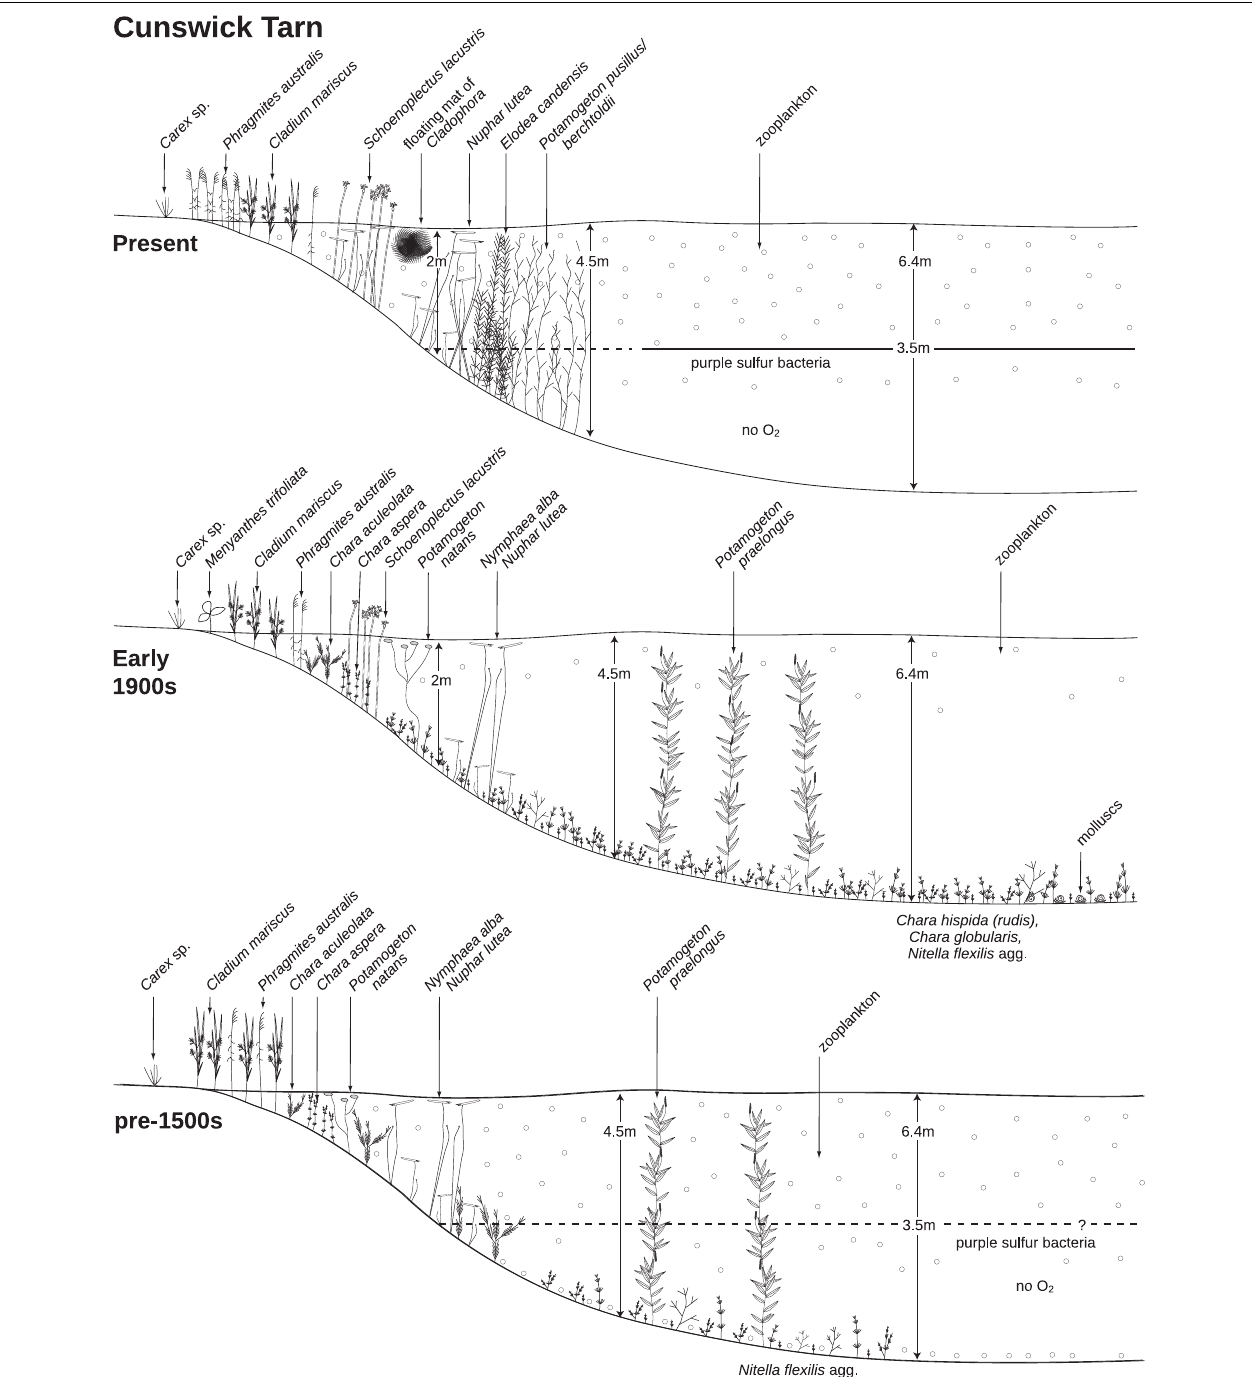
FIGURE 8 | Cross sections of macrophyte cover, showing the currently dominant community, and historical communities based on available historical data.